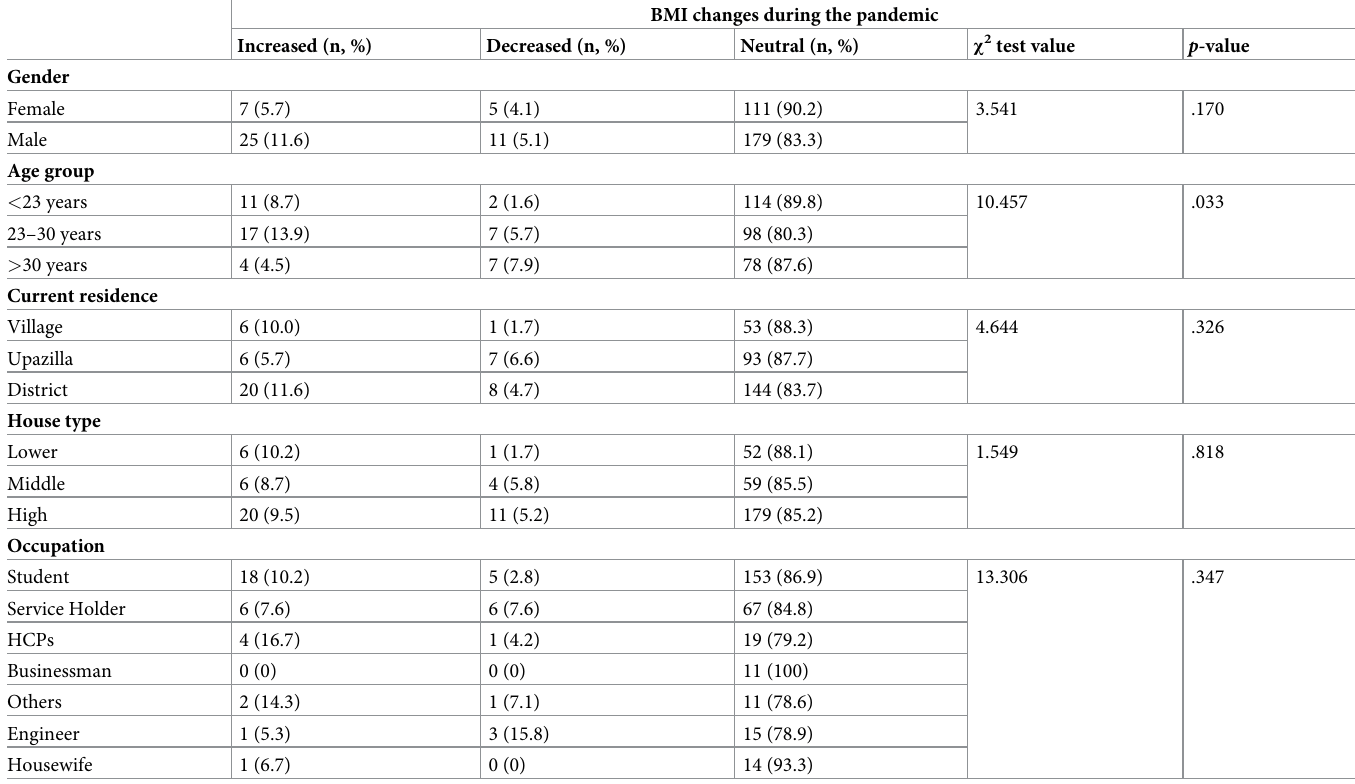
Table 3. Associations between socio-demographic variables and BMI